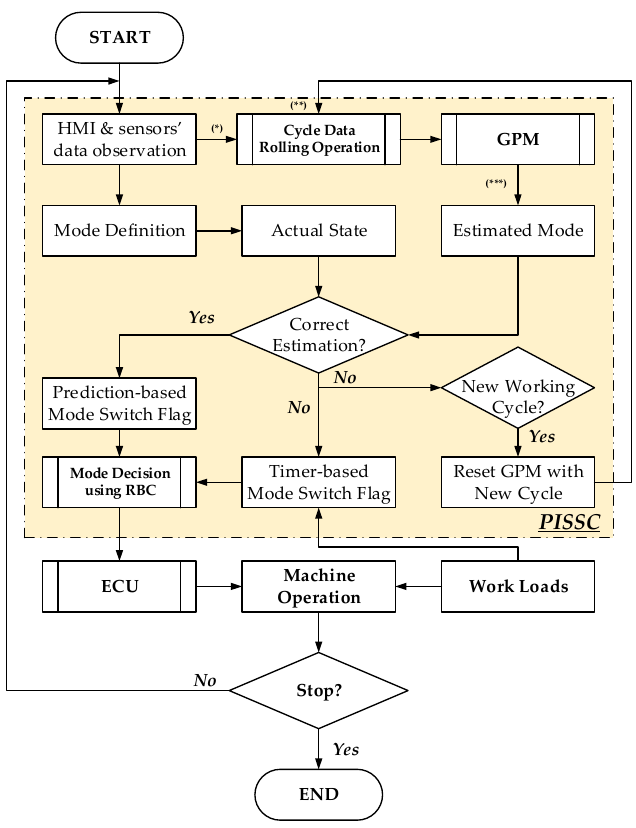
Figure 3. PISSC-based engine control principle [12].